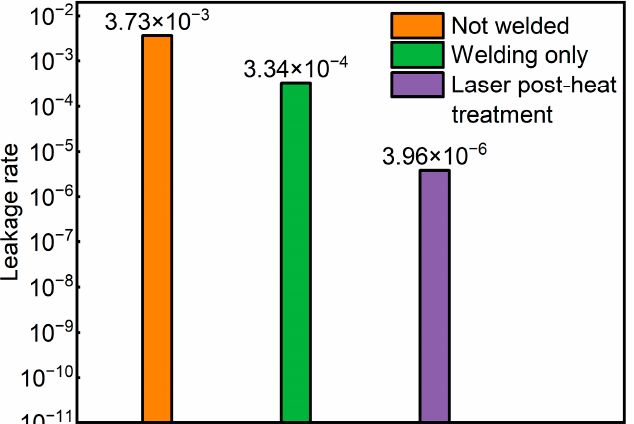
Figure 17. Helium leak test.